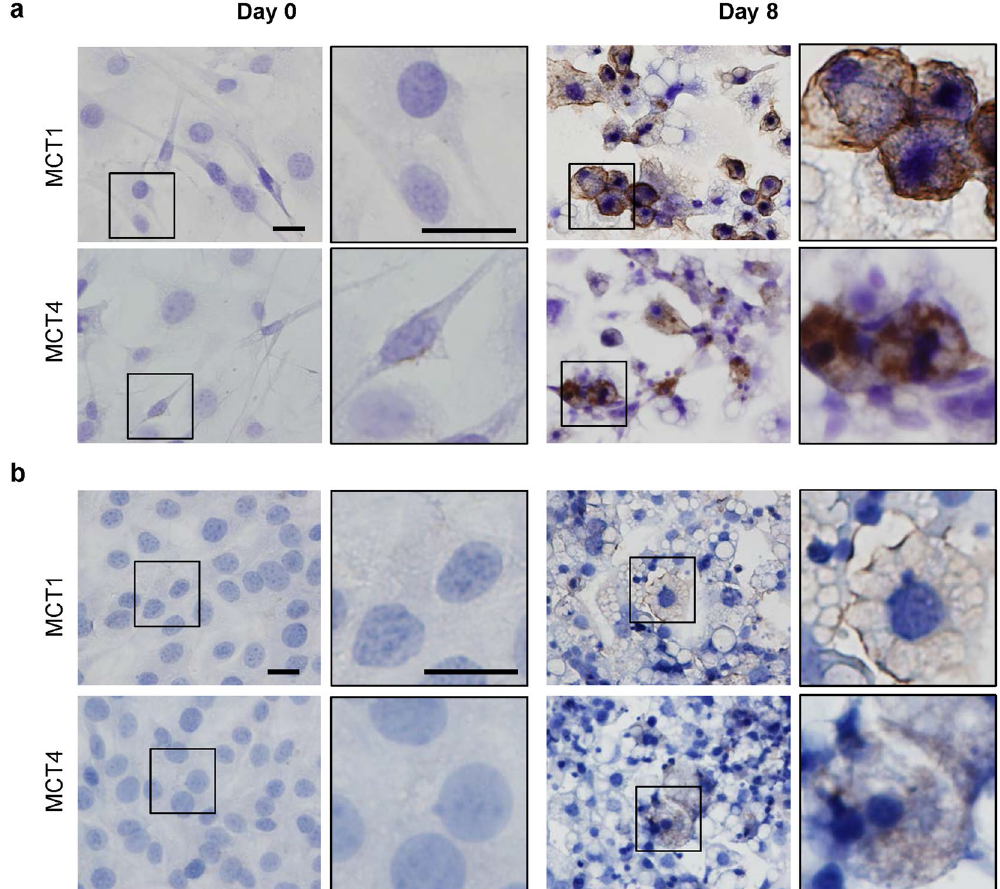
Figure 3. MCT1 and MCT4 localization in undifferentiated and differentiated 3T3-L1 and WT-1 adipocytes. 3T3-L1 ( a ) and WT-1 ( b ) pre-adipocytes were grown on glass coverslips, and either paraformaldehyde-fixed at this point (day 0), or differentiated to adipocytes as described in Materials and Methods, and fixed on day 8. Specimens were subjected to chromogenic staining with antibodies against MCT1 or MCT4 as indicated, and images were acquired at 40x magnification. Zoomed images are magnified from the regions marked with black boxes. Data are representative of 3 (3T3-L1) and 2 (WT-1) biological replicates. Scale bars: 20 µ m for